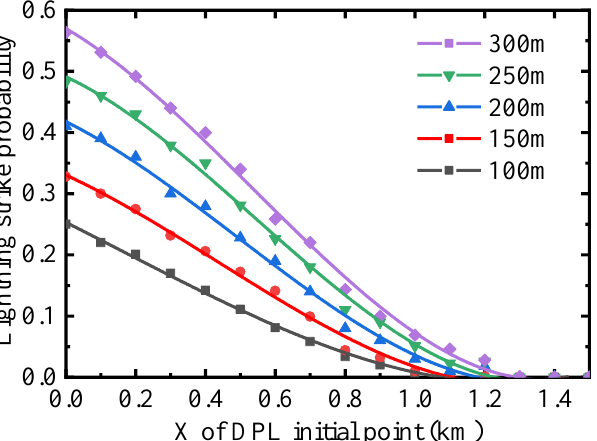
Figure 8. The +CG lightning strikes probability of wind turbines at five heights with the lateral distance of the DPL initial point.